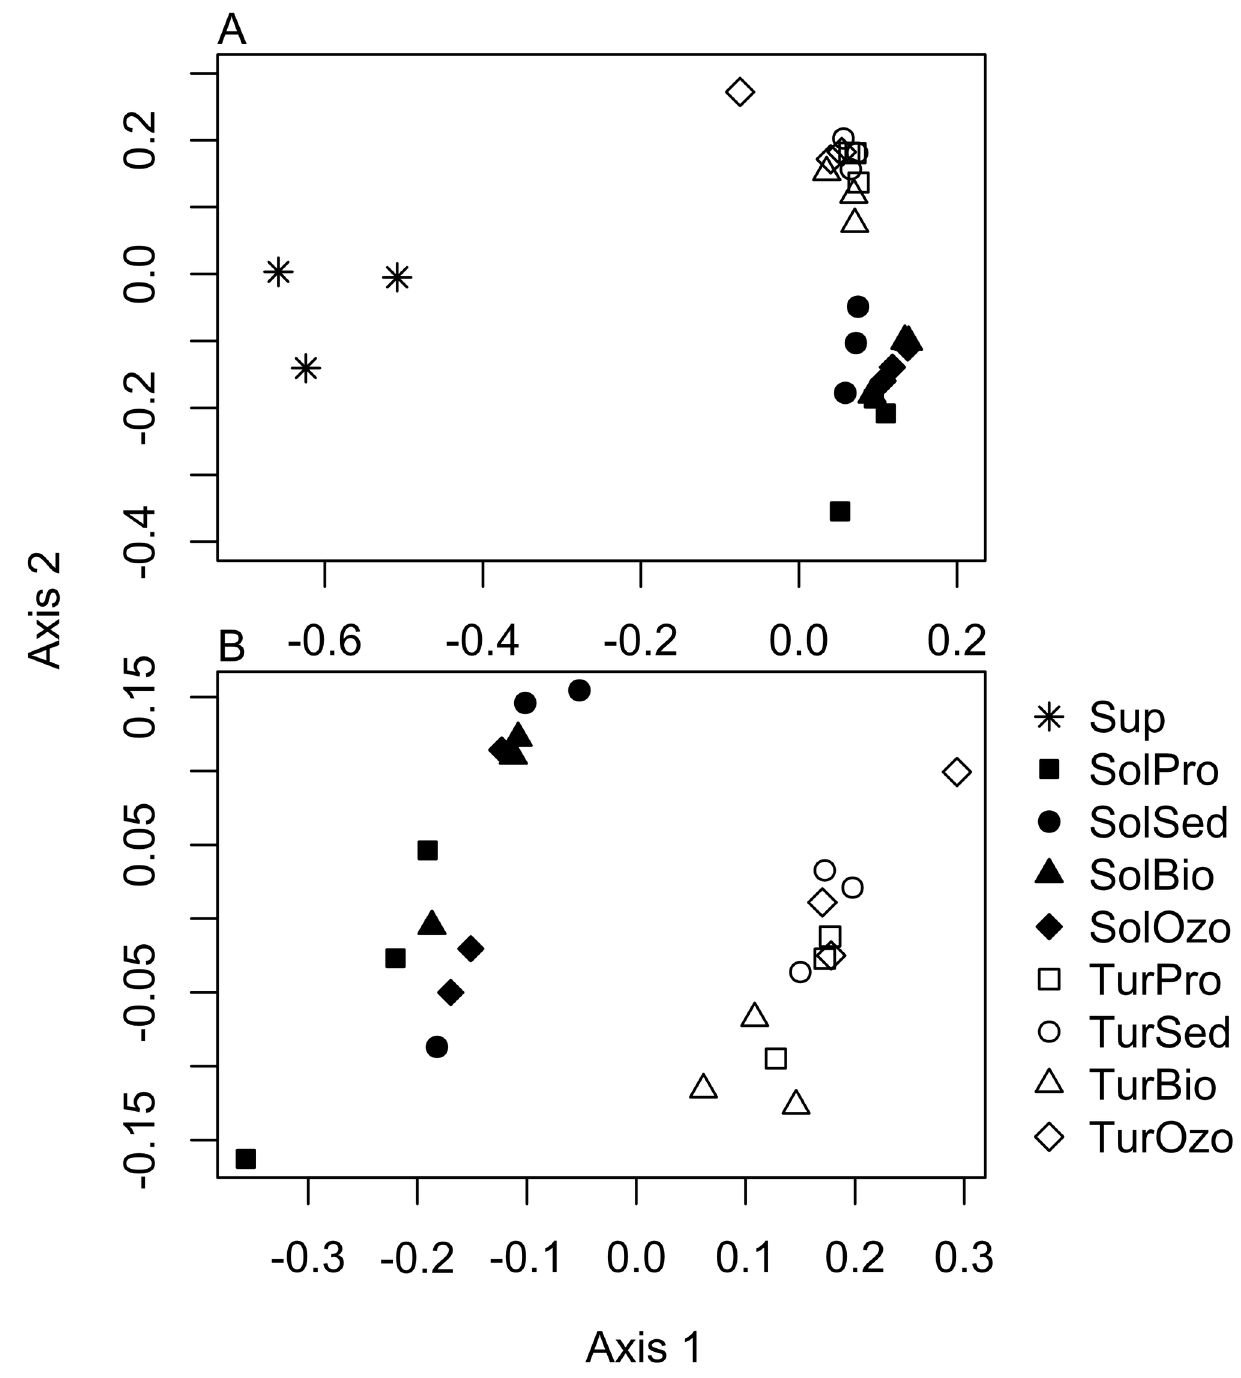
Figure 2. Ordination diagrams (PCO) of the bacterial community based on DGGE profile. A) in all sampling compartments (water supply (Sup), turbot production tank (TurPro), turbot sedimentation tank (TurSed), turbot biofilter tank (TurBio), turbot ozone tank (TurOzo), sole production tank (SolPro), sole sedimentation tank (SolSed), sole biofilter tank (SolBio), sole ozone tank (SolOzo)); B) only in turbot and sole sampling compartments (without water supply).